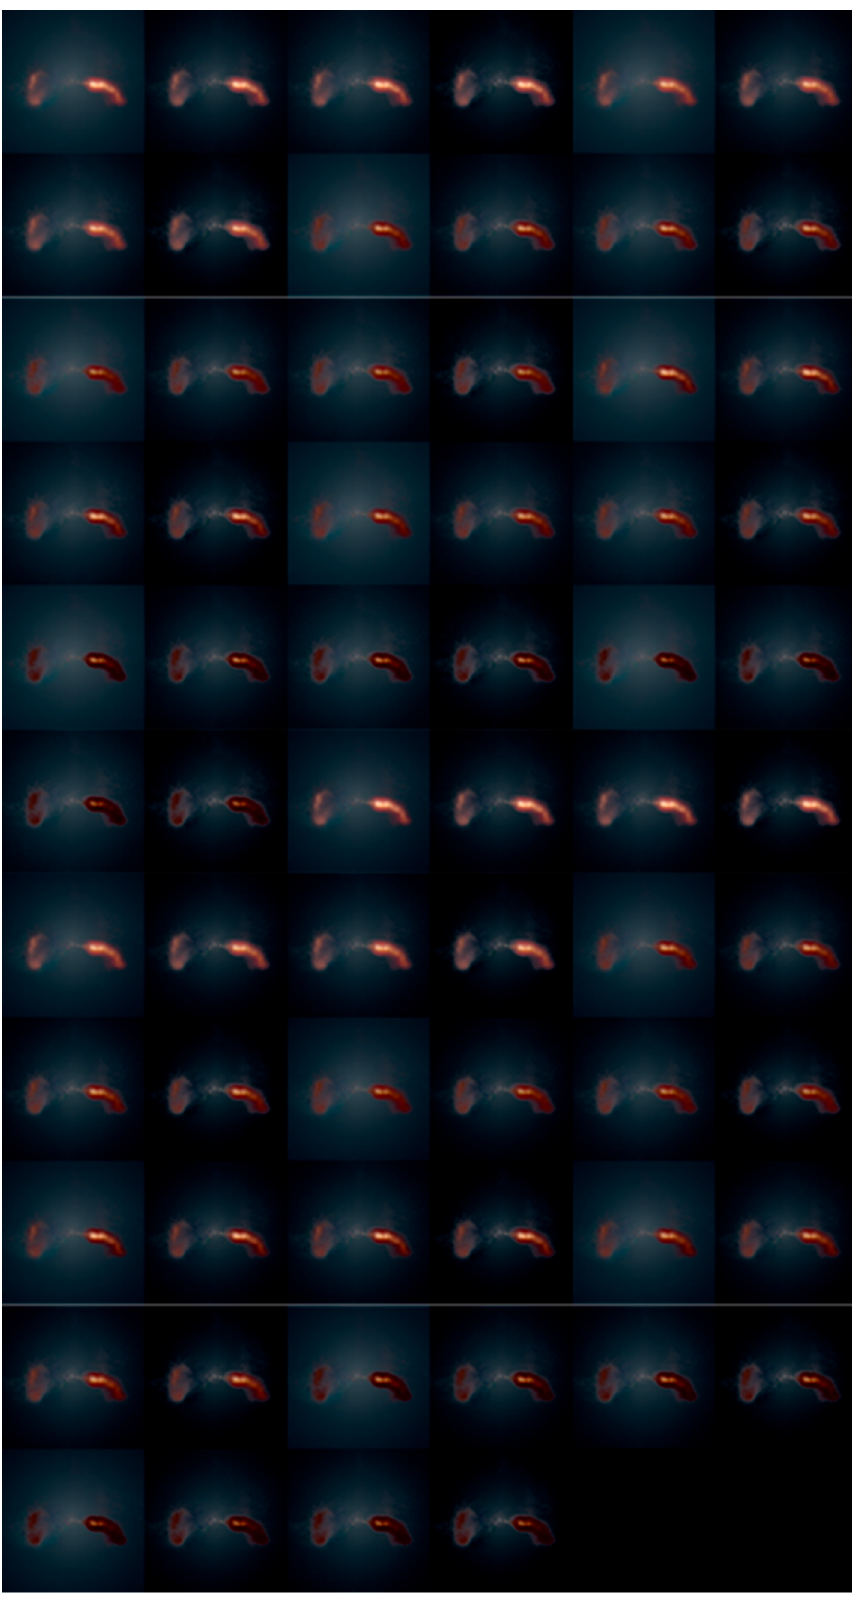
Figure 9. Collage of M87 ′ s galactic core for 63 ISED-generated images. The original image is subfigure 1, top left and 63 ISED-generated images subfigures 2–64 of M87. The ISED ensemble states of the images are displayed in Appendix A. Full-sized images are available online at [7].